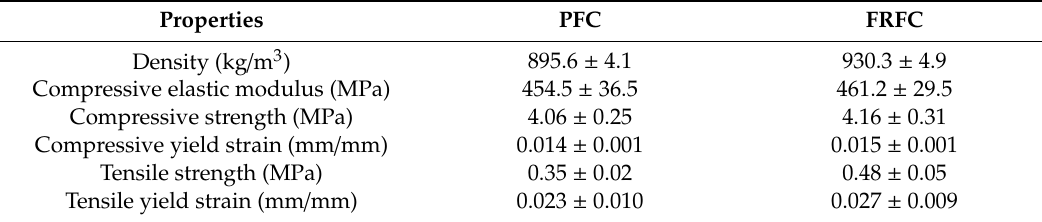
Table 1. Mechanical properties of PFC and FRFC.